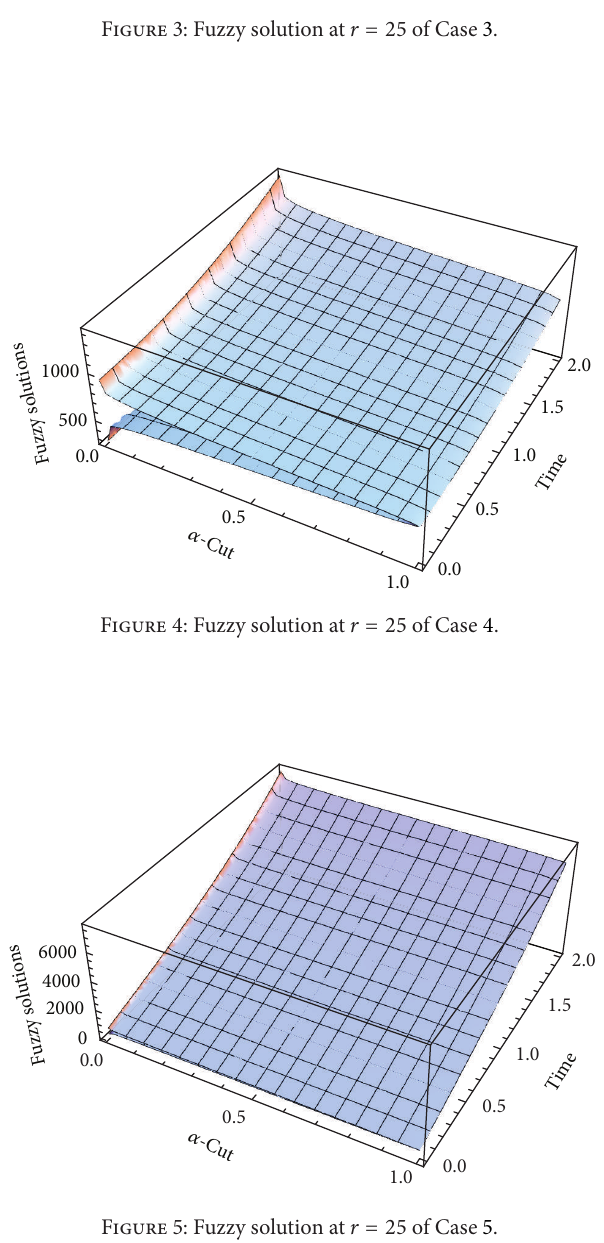
Figure 5: Fuzzy solution at 𝑟 = 25 of Case 5.